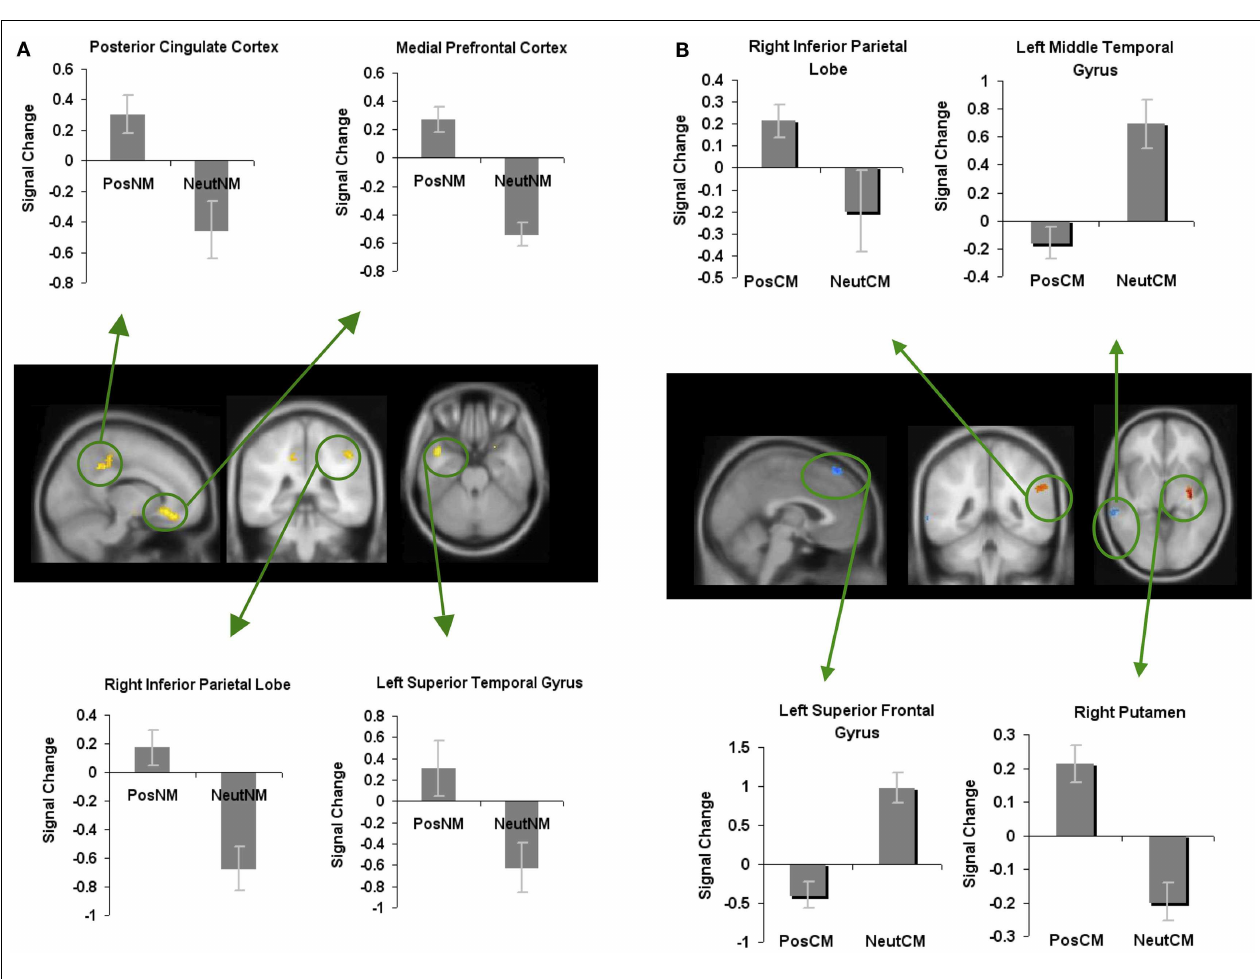
conventional metaphors . All clusters are illustrated at a threshold of p < 0.001 (uncorrected) combined with a cluster size of at least 50 voxels or 400mm 3 in volume. Mean beta weights for each condition extracted from the clusters illustrated in the specific contrasts of interest are revealed in the bar